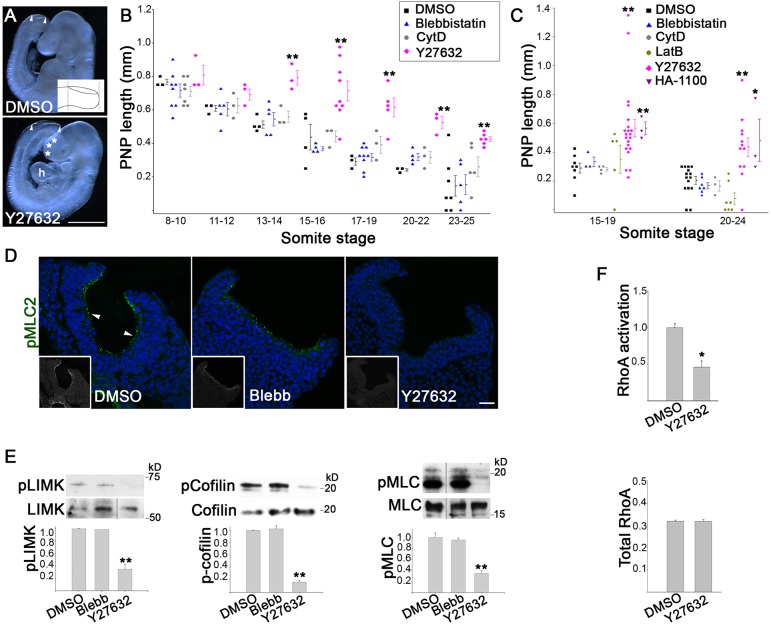
Inhibition of RhoA signalling disrupts spinal neural tube closure. (A) Mouse embryos cultured for 18 h to the 24 somite stage. Exposure to 5 µM Y27632 yields an enlarged PNP (between arrowheads), open forebrain (asterisks) and defective heart looping (h) compared with the DMSO control. Inset, method of PNP length measurement, between the dashed lines. Scale bar: 0.5 mm. (B) Progressive closure of PNP is arrested after the 13 somite stage in embryos cultured for 5–6 h in Y27632 (**P<0.001 versus DMSO). Embryos exposed to 50 µM Blebbistatin or 0.05 µg/ml CytD close at the same rate as DMSO controls. (C) PNP closure is significantly delayed after culture in ROCK inhibitor Y27632 or HA-1100, for 18–20 h to the 15–19 or 20–24 somite stage (**P<0.001 versus DMSO). Embryos cultured in Blebbistatin, CytD or LatB resemble DMSO controls. (D) Immunohistochemistry (green, anti-pMLC; nuclei, DAPI) shows apically localized pMLC (arrowheads) in DMSO- and Blebbistatin-treated embryos with 19 somites. The signal is abolished by 5–6 h culture in Y27632. Grayscale insets, pMLC staining only. Scale bar: 30 µm. (E) Western blots for pLIMK and LIMK, p-cofilin and cofilin, and pMLC and MLC. The level of the phosphorylated forms are quantified as a proportion of the total, after normalizing to GAPDH. Culture for 5–6 h in Y27632 significantly reduces the relative amount of pMLC, pLIMK and p-cofilin compared with DMSO controls, whereas Blebbistatin has no effect (n=3, **P<0.001). (F) G-LISA assay of active GTP-bound RhoA (top) relative to total RhoA (below), normalized to DMSO (mean±s.d.). Y27632-treated embryos have significantly reduced RhoA activation whereas total RhoA does not differ between treatments (n=3, *P<0.001). Significance values were calculated with a Student's t-test, compared with DMSO control.